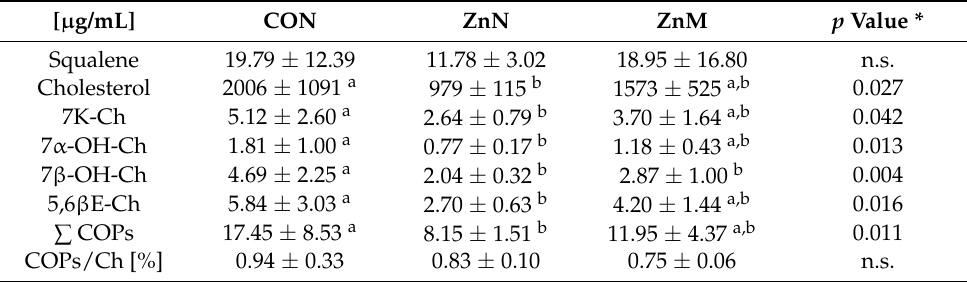
Data are presented as mean values ± standard deviation. * statistically significant difference ( α = 0.05), a,b —homogenous groups in rows ( α = 0.05), n.s.—not significant; CON—control group; ZnM—group receiving zinc in microparticles; ZnN—group receiving zinc in nanoparticles; 7-ketocholesterol (7K-Ch); 7 α -hydroxycholesterol (7 α -OH-Ch); 7 β -hydroxycholesterol (7 β -OH-Ch); 5 β ,6 β -epoxycholesterol (5,6 β E-Ch), COPs—cholesterol oxidation products; ∑ COPs—sum of COPs.